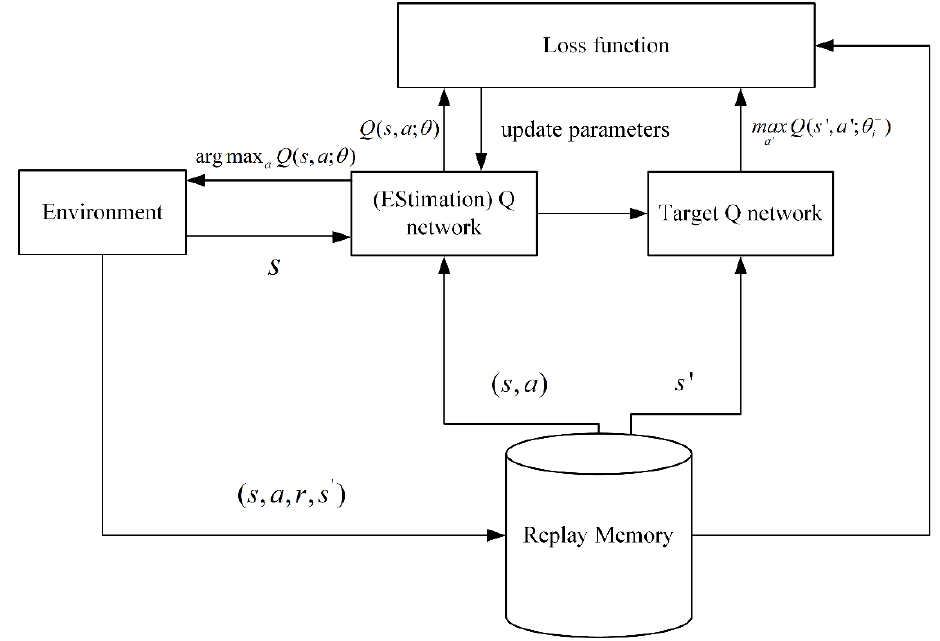
Figure 2. Principle of DQN.